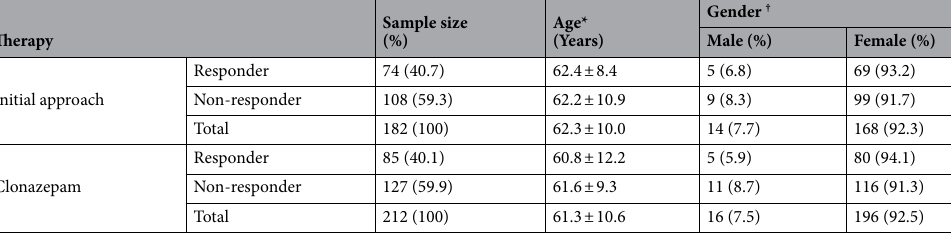
Table 2. Sample size, age and gender ratio of both treatment groups used to build machine learning models, mean ± S.D., n (%). Responder, subjects whose visual analog scale (VAS) score on oral symptoms decreased more than 2 points after 1 month of the treatment compared with before treatment. Non-responder, subjects whose VAS scores of oral symptoms decreased less than 2 points or experienced symptom worsening after 1 month of the treatment compared with before treatment. * P -values of Student’s t-test between the responders and non-responders in the initial approach and clonazepam groups were 0.913 and 0.614, respectively. † P -values of chi-square test with correction in the initial approach and clonazepam groups were 0.913 and 0.627,